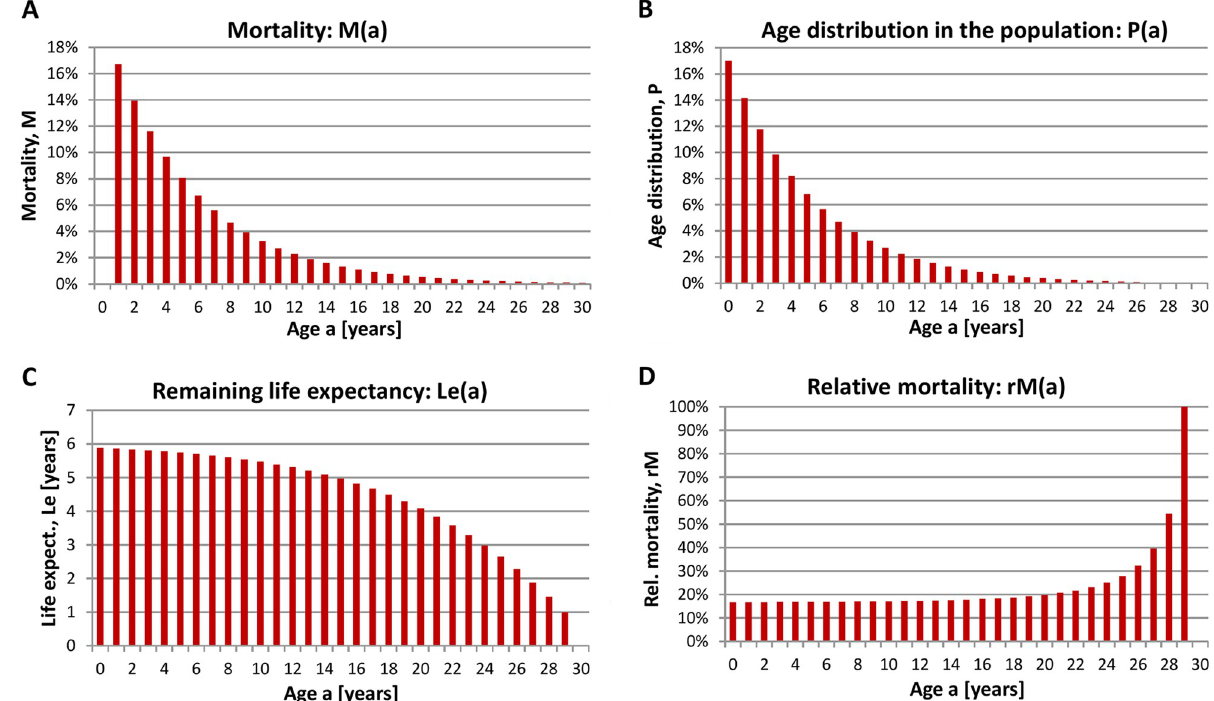
Fig 3. Population dynamics of Whooper Swans. (A) Mortality, M(a) (probability of dying at a given age), (B) age distribution in the January population P(a), (C) remaining life expectancy at a given age Le(a), and (D) relative mortality rM(a) (probability of dying when a certain age has been reached) of the Whooper Swan. Calculations are based on age-differentiated bird counts determined during January in Germany (2012–2020, whole country of Germany). Raw data are from the database ornitho . de .